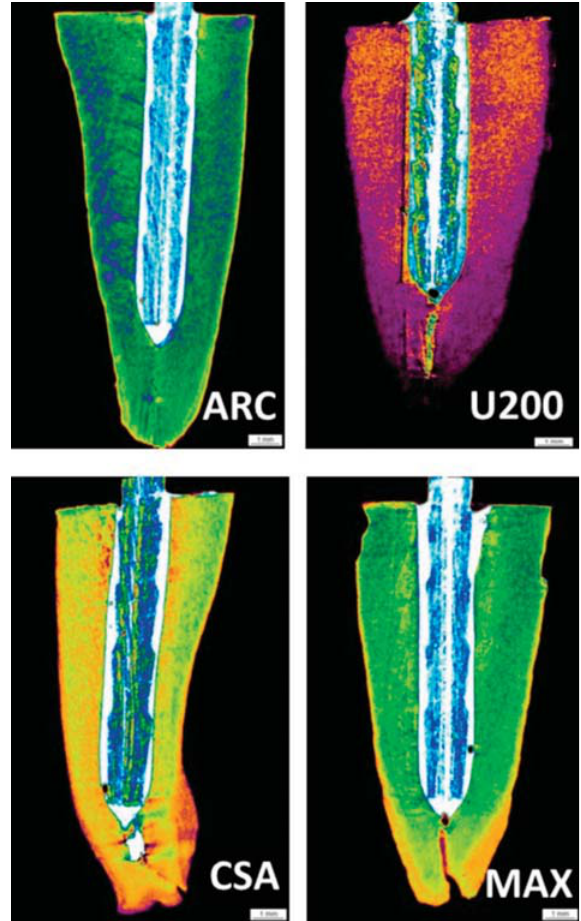
Figure 4- μ CT scanning of the roots cemented using the resin cements ARC (ARCA), RelyX U200 (U200), (cid:38)(cid:79)(cid:72)(cid:68)(cid:85)(cid:191)(cid:79)(cid:3)(cid:54)(cid:36)(cid:3)(cid:37)(cid:82)(cid:81)(cid:71)(cid:3)(cid:11)(cid:38)(cid:54)(cid:36)(cid:12)(cid:15)(cid:3)(cid:68)(cid:81)(cid:71)(cid:3)(cid:48)(cid:68)(cid:91)(cid:70)(cid:72)(cid:80)(cid:3)(cid:40)(cid:79)(cid:76)(cid:87)(cid:72)(cid:3)(cid:11)(cid:48)(cid:36)(cid:59)(cid:12)(cid:17)(cid:3)(cid:55)(cid:75)(cid:72)(cid:3) percentage of bubbles, voids, and gaps was lower using a commercial delivery syringe (Centrix) to apply the cement into the root